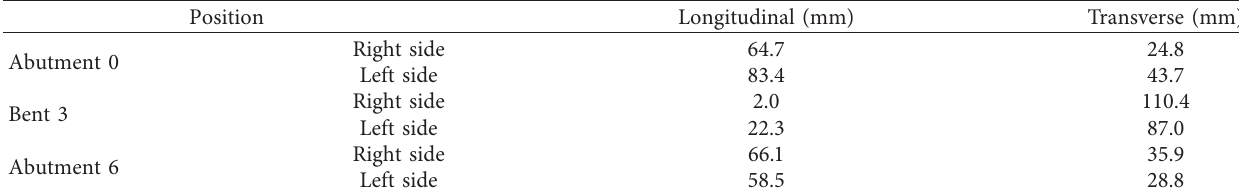
Table 3: Calculated residual relative displacement between two adjacent